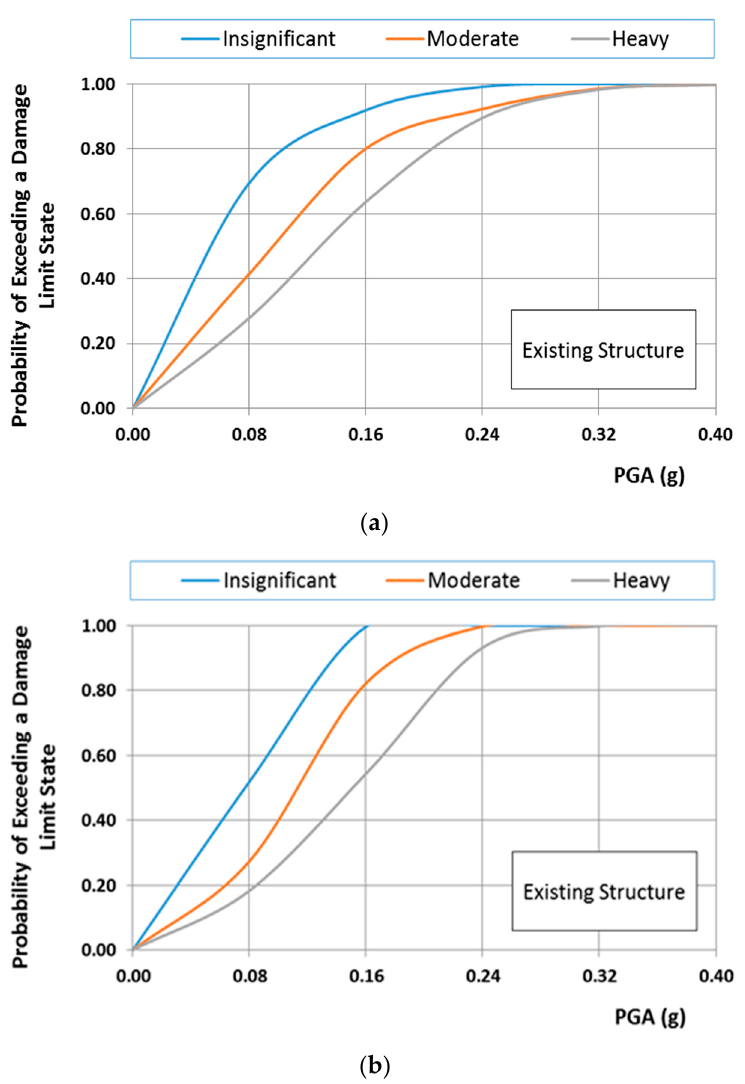
Figure 12. Fragility curves of existing structure normal distribution: ( a ) normal distribution; ( b ) lognormal distribution.